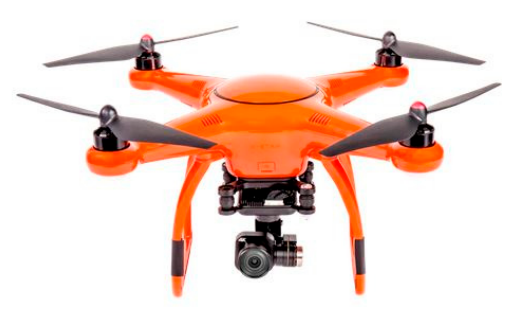
Figure 1. Autel X-star drone [37].